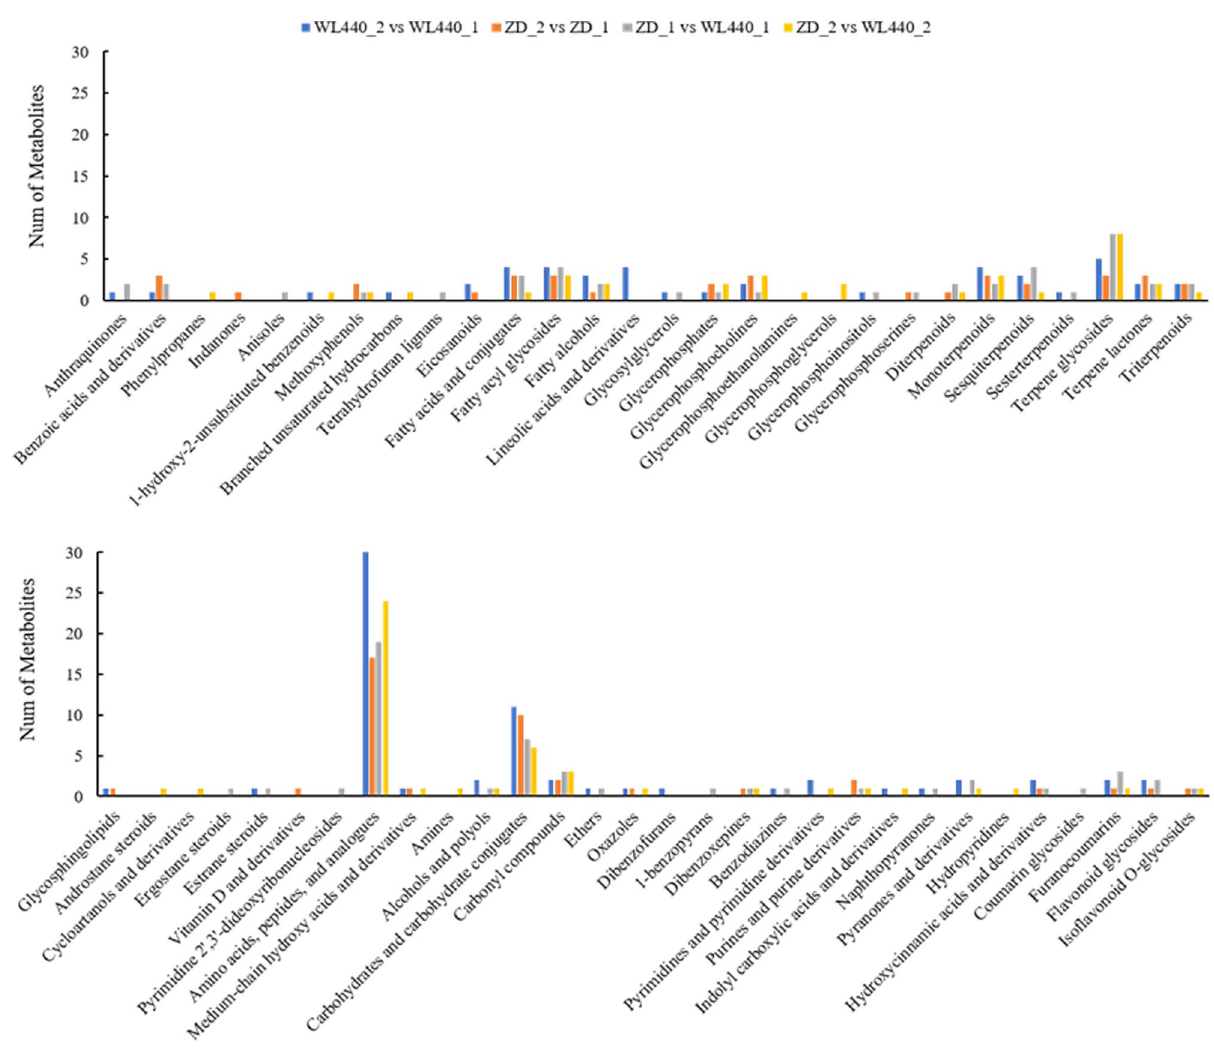
Figure 6. Classification of differential metabolites in four pairwise comparisons. Note : The abscissa represents the names of the 58 subclasses level of differential metabolites in the four pairwise prenol lipids, fatty acyls, carboxylic acids and derivatives, and glycerophospholipids. Carboxylic acids and deriva- tives, organooxygen compounds, and prenol lipids were the main differential metabolites that were up-regulated in the WL440_2 vs WL440_1, ZD_2 vs ZD_1, and ZD_2 vs WL440_2 comparisons, whereas carboxylic acids and derivatives, prenol lipids, and glycerophospholipids were the main up-regulated differential metabolites in the ZD_1 vs WL440_1 comparison. Carboxylic acids and derivatives and prenol lipids were identified as down- regulated differential metabolites in all pairwise comparisons. The other identified down-regulated differential metabolites included fatty acyls in the WL440_2 vs WL440_1 and ZD_2 vs ZD_1 comparisons, glycerophospho- lipids in the ZD_2 vs ZD_1 and ZD_2 vs WL440_2 comparisons, and organooxygen compounds in the ZD_1 vs WL440_1 and ZD_2 vs WL440_2 comparisons.